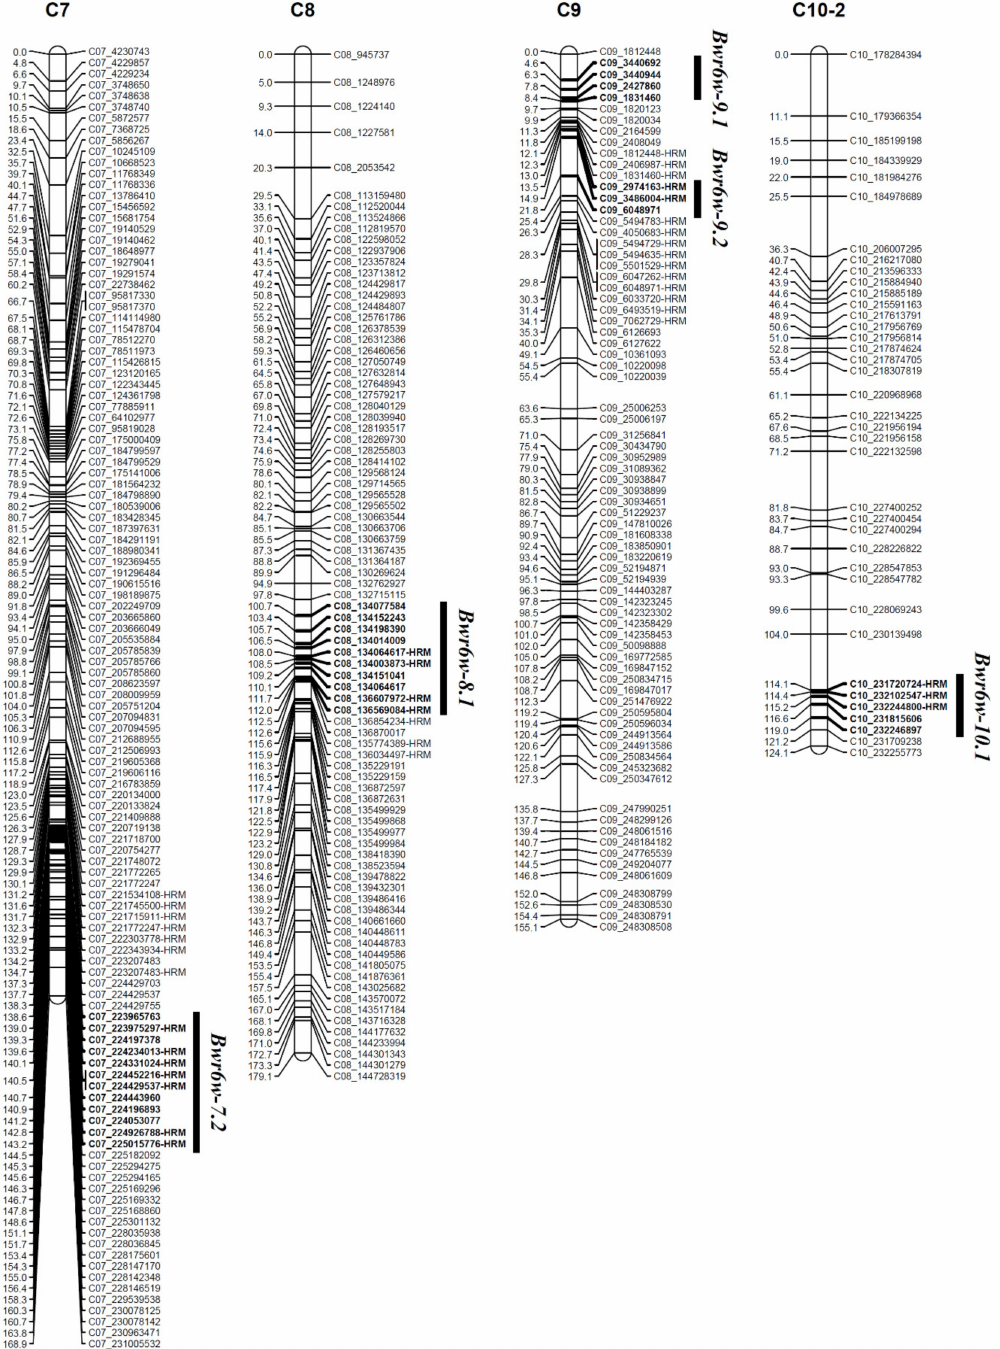
Figure 2. Map position of QTLs for the resistance to bacterial wilt caused by a moderately pathogenic ‘HS’ isolate of Ralstonia solanacearum in an F 2 population of the strongly resistant hybrid pepper cultivar ‘Konesian Hot’. Bar left number, genetic position (cM); bar right name, name of SNP marker; bold, markers located within each QTL